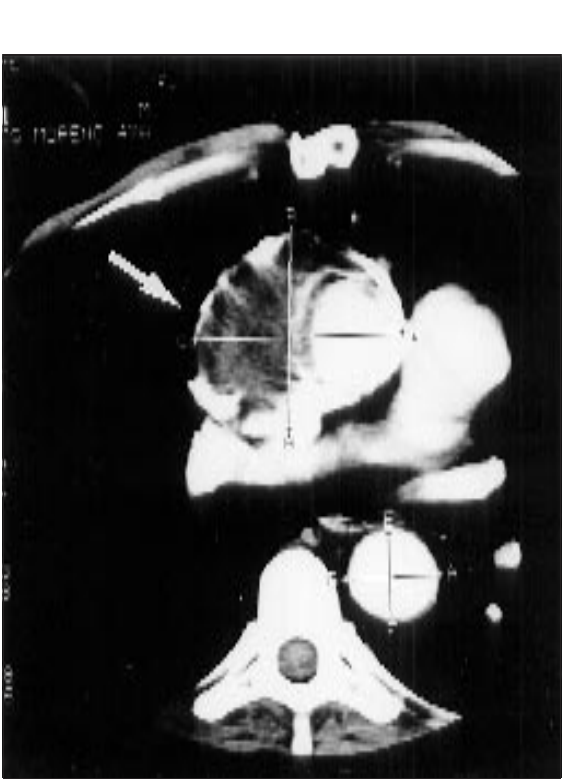
Fig. 2 - Tomografia computadorizada de tórax mostrando aneurisma de aorta ascendente e presença de grande trombo mural (seta).